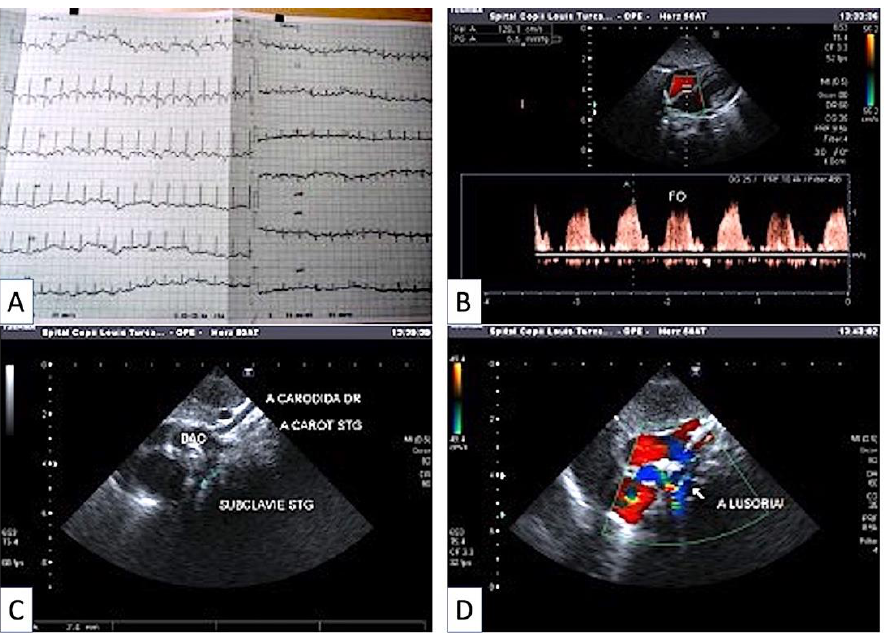
Figure 2. Cardiovascular assessment of the patient. Electrocardiogram appearance ( A ): RS regular 154 beats/min, axis QRS + 135 physiologically deviated to the right, otherwise normal electrical path. Blood flow presence through foramen ovale ( B ). Aortic arch to the left, from which emerge the right carotid artery, the left carotid artery, the left subclavian artery ( C ), and the right subclavian artery, which most often has a retroesophageal route = lusoria artery is observed ( D ).